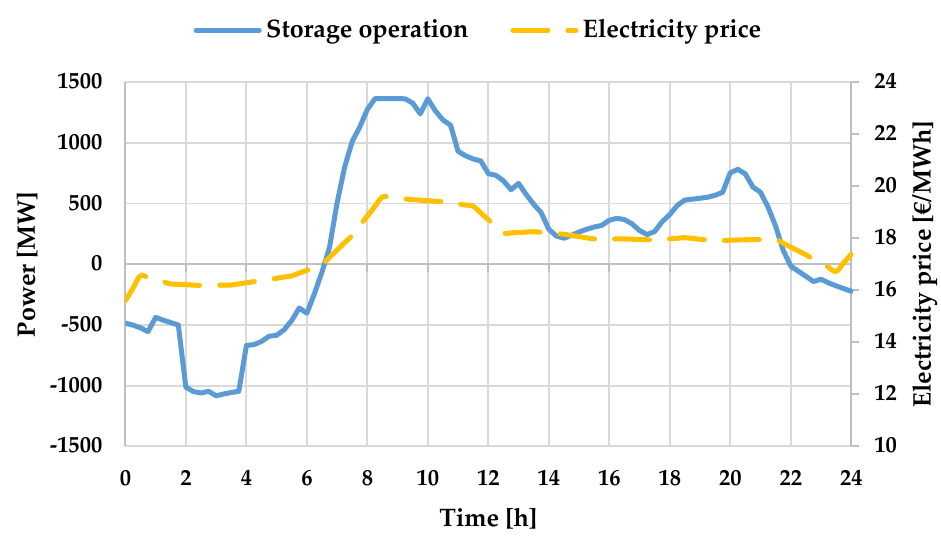
Figure 7. Daily operation of the storage in the dynamic pricing environment.